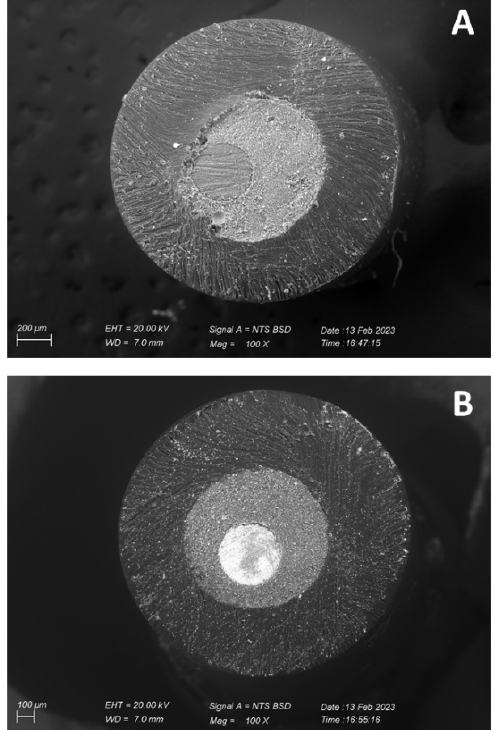
Figure 7. Scanning electron micrographs (100 × magnification) of control PL (Panel ( A )) and platinized PL (Panel ( B )).